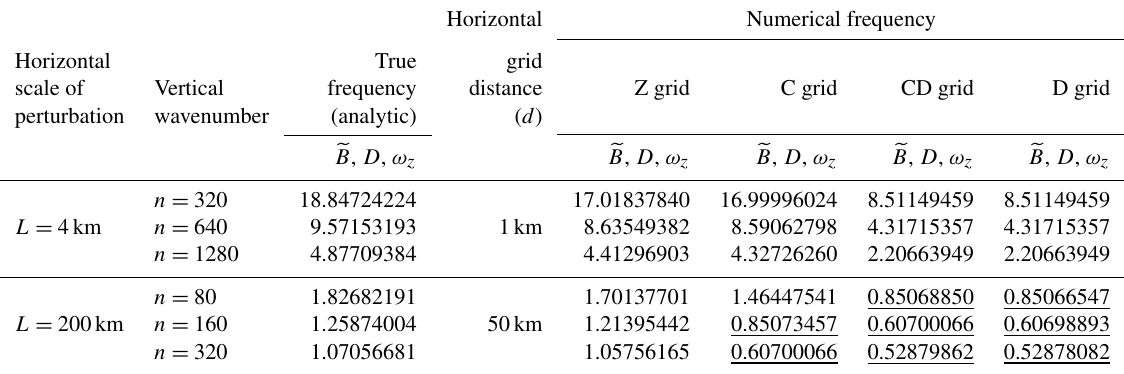
Table 4. Same as Table 3 but using d = L/ 4. Underlined numbers indicate frequencies less than the minimum frequency of inertial oscillation (10 − 4 s − 1 )